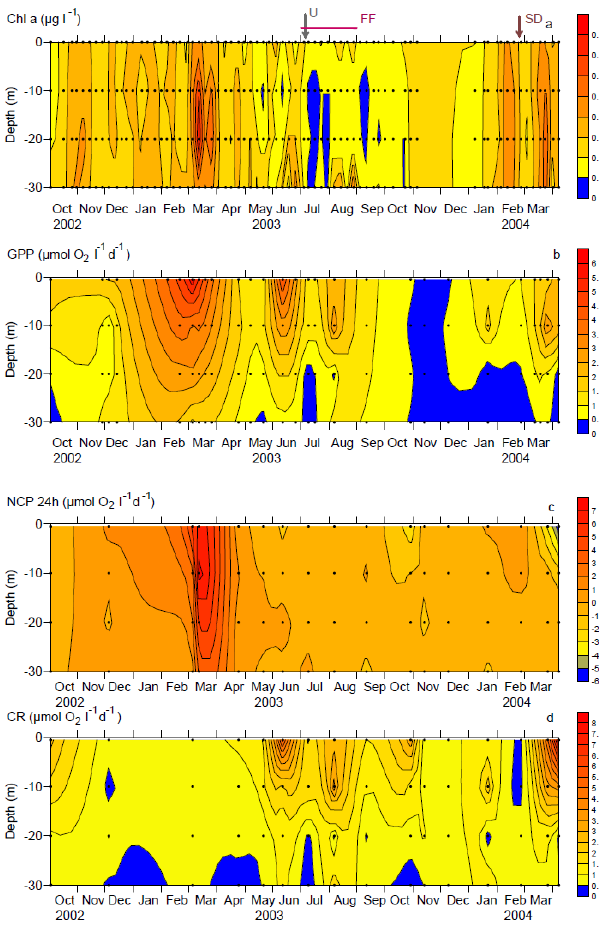
Fig. 7. Changes in phytoplankton and community parameters dur- ing the study period for the upper 30m of the water column. Chl- a data were collected on a weekly basis. The dots represent sampling dates. (a) Chl- a , (b) gross primary production (GPP), (c) net com- munity production (NCP) and (d) community respiration ( R ). SD, Sahara dust deposition event, FF, forest fire period; U, upwelling event.